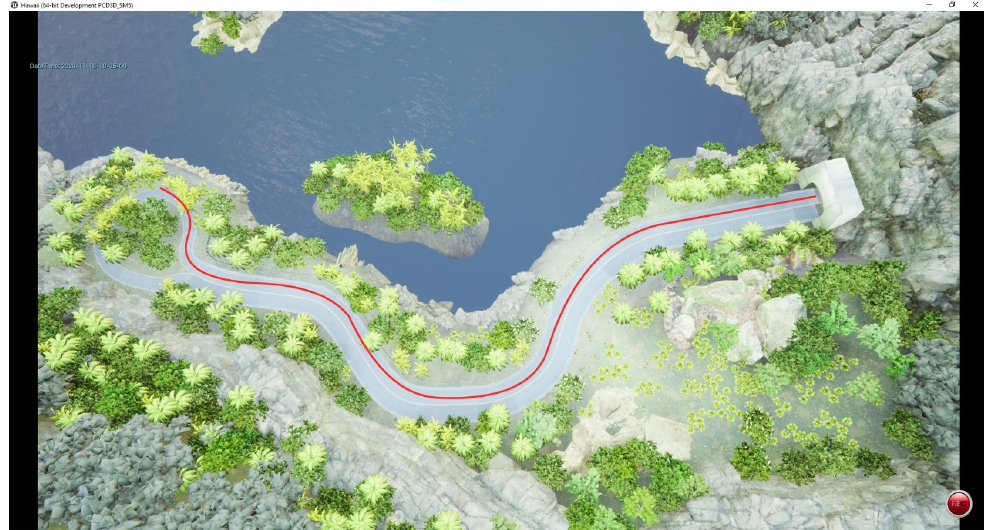
Figure 14. The trajectory of the testing path of the DDPG.